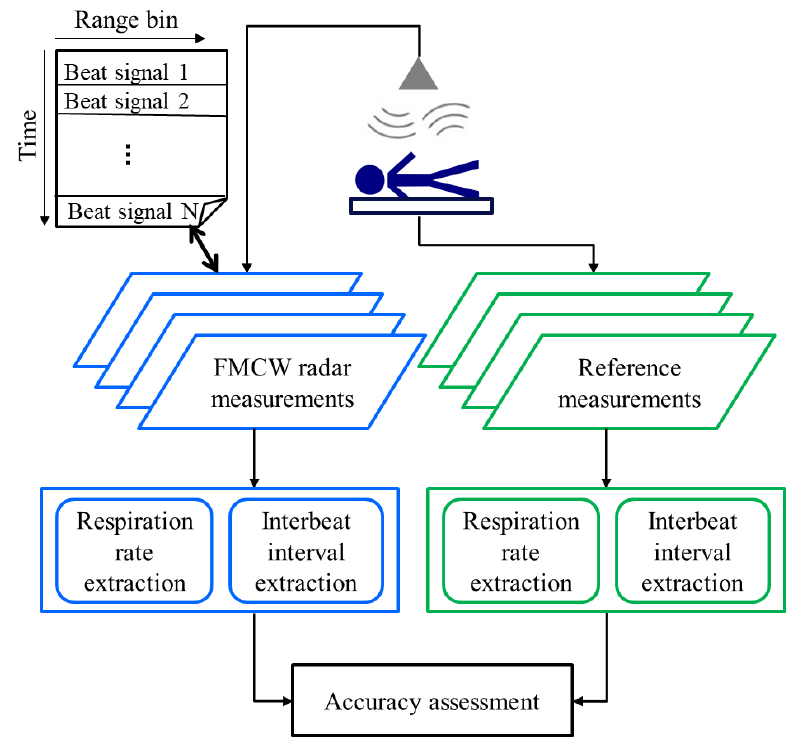
Figure 1. The overall measurement and evaluation workflow. The radar and reference data are processed separately. A beat signal describes the difference between the transmitted and received signals.